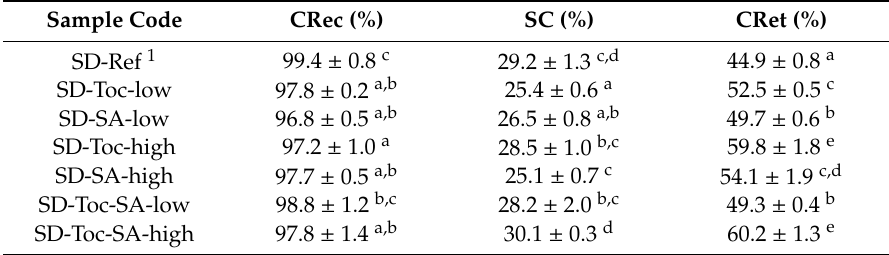
1 SD-Ref values are included for direct comparison and represent the same dataset as in Table 2. Means within the same column followed by di ff erent letters are statistically significant di ff erent ( p ≤